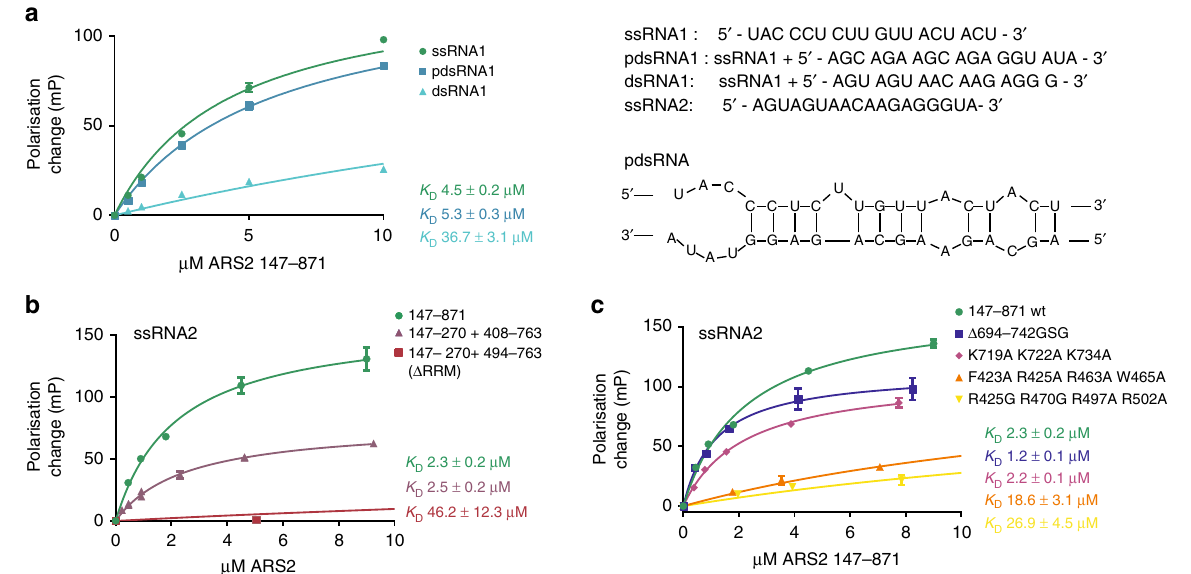
Fig. 3 The RRM domain of ARS2 binds single-stranded RNA. FAM-labelled RNA and fl uorescence polarisation measurements were used to determine the af fi nity of various RNAs to hARS2. See also Supplementary Fig. 5. a Recombinant ARS2 147 – 871 was titrated to FAM-labelled single-stranded (ss), partially double-stranded (pds) and double-stranded (ds) RNA and the polarisation measured for each concentration. b ARS2 147 – 871 , ARS2 147 – 270 + 408 – 763 and ARS2 147 – 270 + 494 – 763 were titrated to FAM-labelled ssRNA and the fl uorescence polarisation measured. c Site-speci fi c mutants of basic residues in the RRM domain, or mutants and deletion in the C-terminal foot of ARS2 147 – 871 , as indicated, were used to further localise the RNA-binding site. The K D was derived by fi tting the data to a single-site binding model. Error bars show SD of three